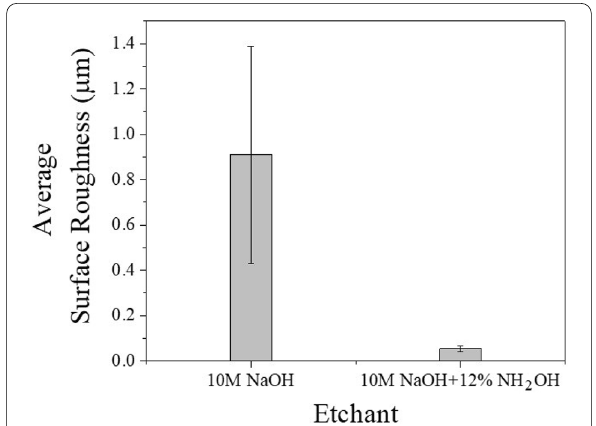
Fig. 9 Effect of etchant (10 M NaOH etched surface